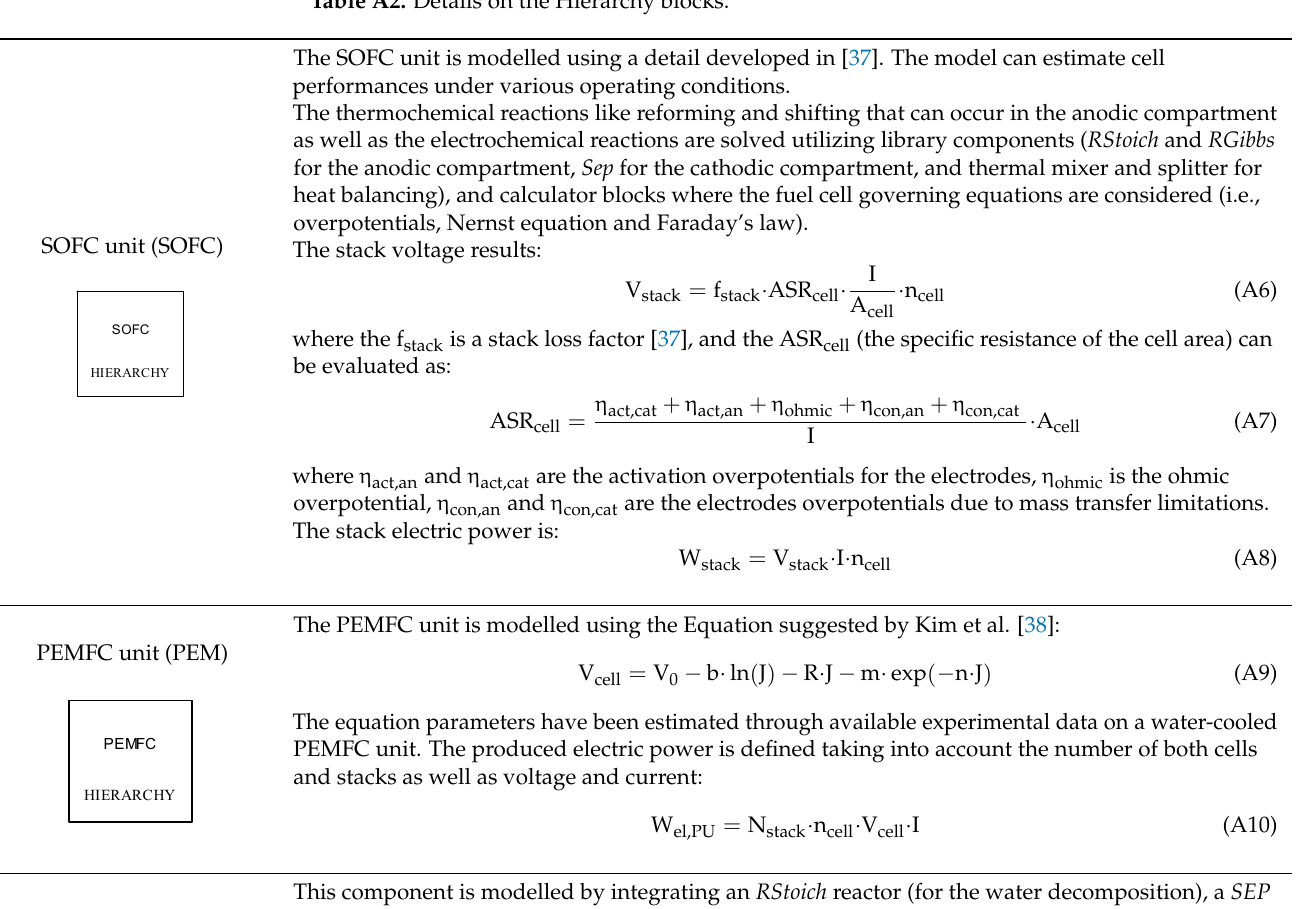
Table A2. Details on the Hierarchy blocks.